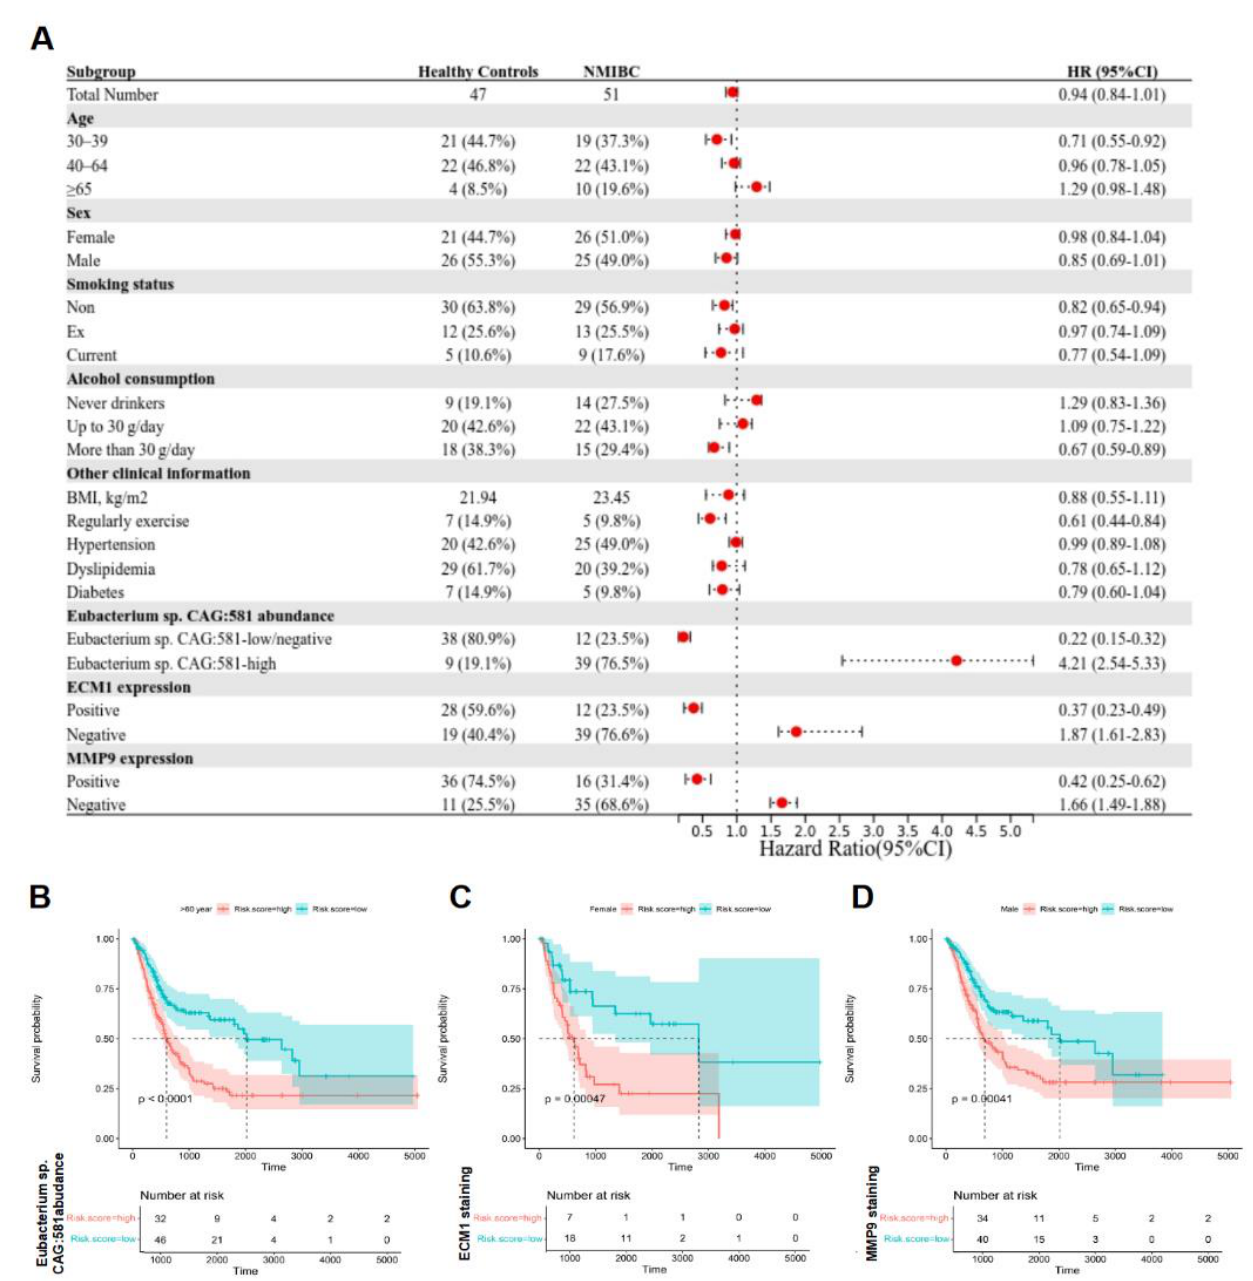
Figure 4. Eubacterium sp. CAG:581 was endowed with the diagnostic predictor for NMIBC. ( A ) Uni- variate analysis of baseline information was performed in 51 NMIBC patients versus 47 healthy controls. The bars correspond to 95% confidence intervals. ( B ) Univariate predictive value of Eubac- terium sp. CAG:581 was compared between 51 NMIBC patients and 47 healthy controls, log-rank test. ( C ) Univariate predictive value of ECM1 was compared between 51 NMIBC patients and 47 healthy controls, log-rank test. ( D ) Univariate predictive value of MMP9 was compared between 51 NMIBC patients and 47 healthy controls, log-rank